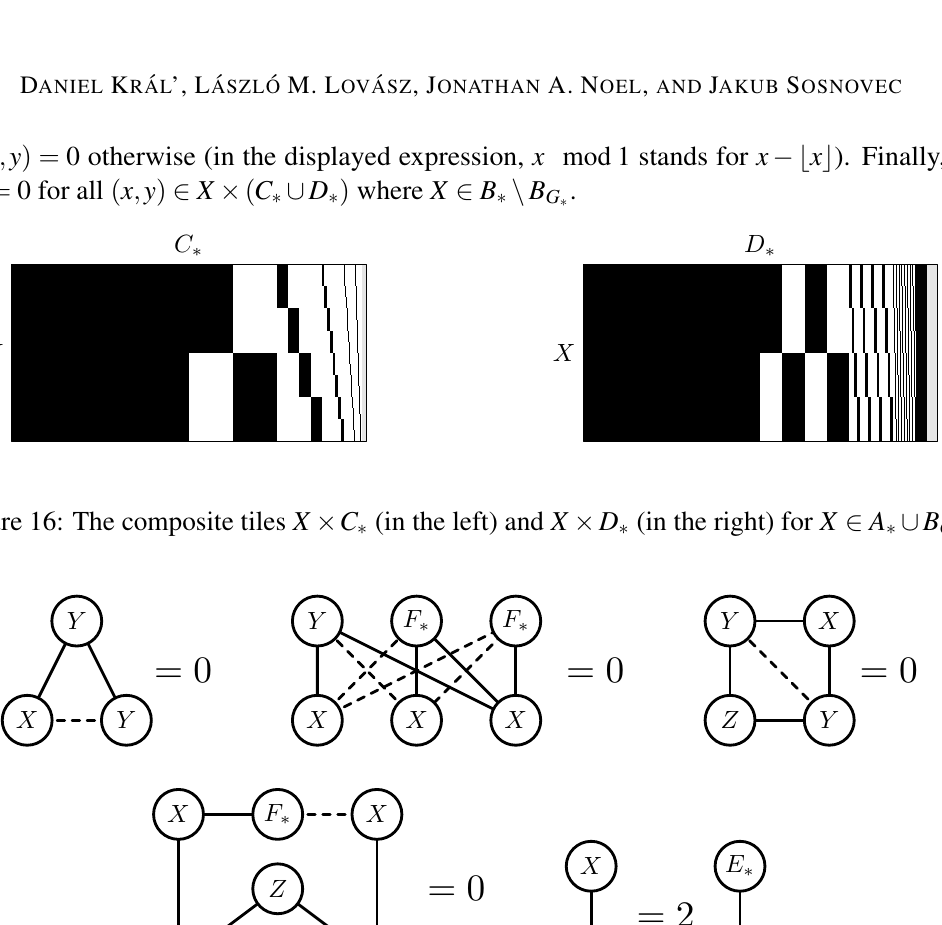
Figure 17: The decorated constraints forcing the structure of the tiles X × C ∗ and X × D ∗ for X ∈ A ∗ ∪ B G The constraints should hold for every such X and for both ( Y , Z ) = ( C ∗ , E ∗ ) and ( Y , Z ) = ( D ∗ , C ∗ )